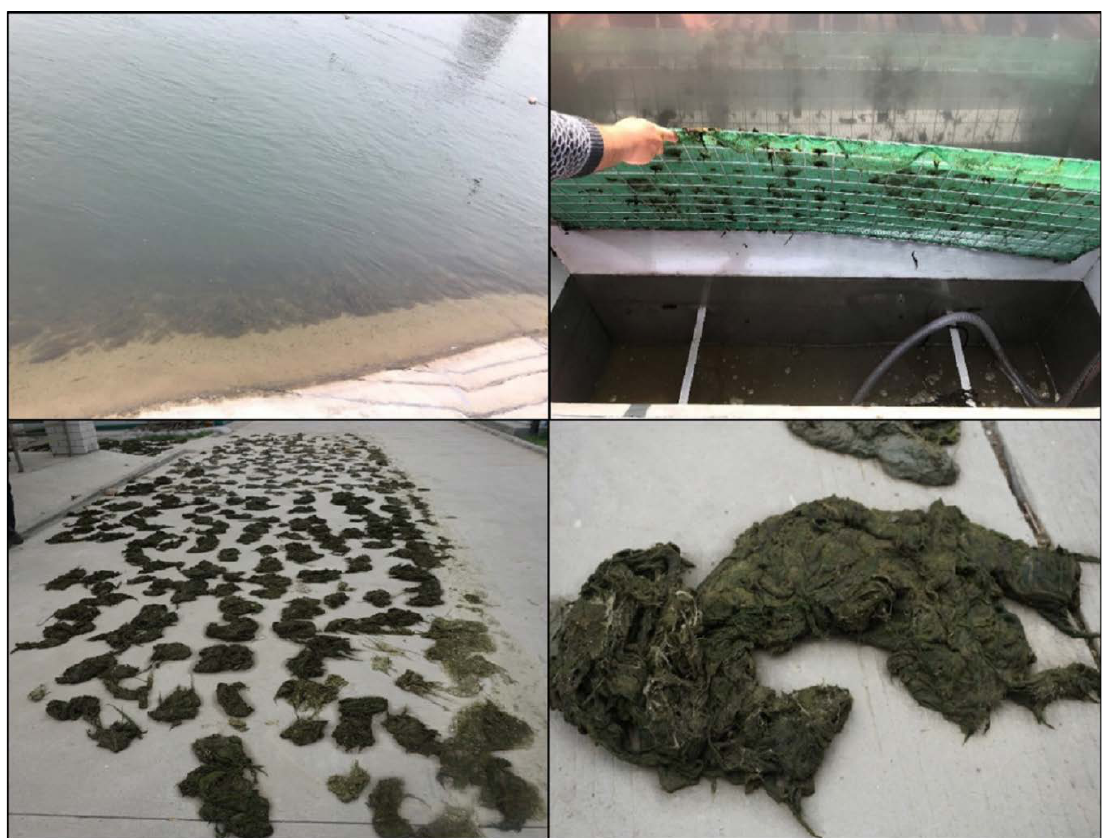
Figure 1. Algae in the main canal of the Middle Route of the South-to-North Water Diversion Project (MRP).